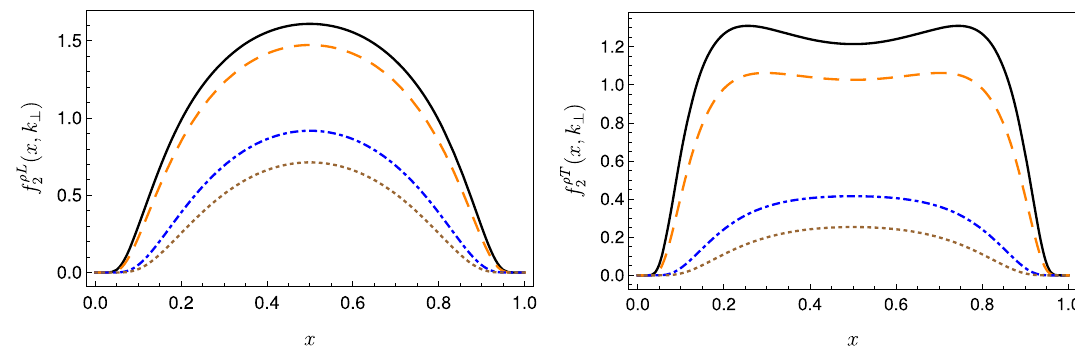
Fig. 16 Same of Fig. 3 for the ρ meson. Left panel for longitudinal polarisation. Right panel for transverse polarisation